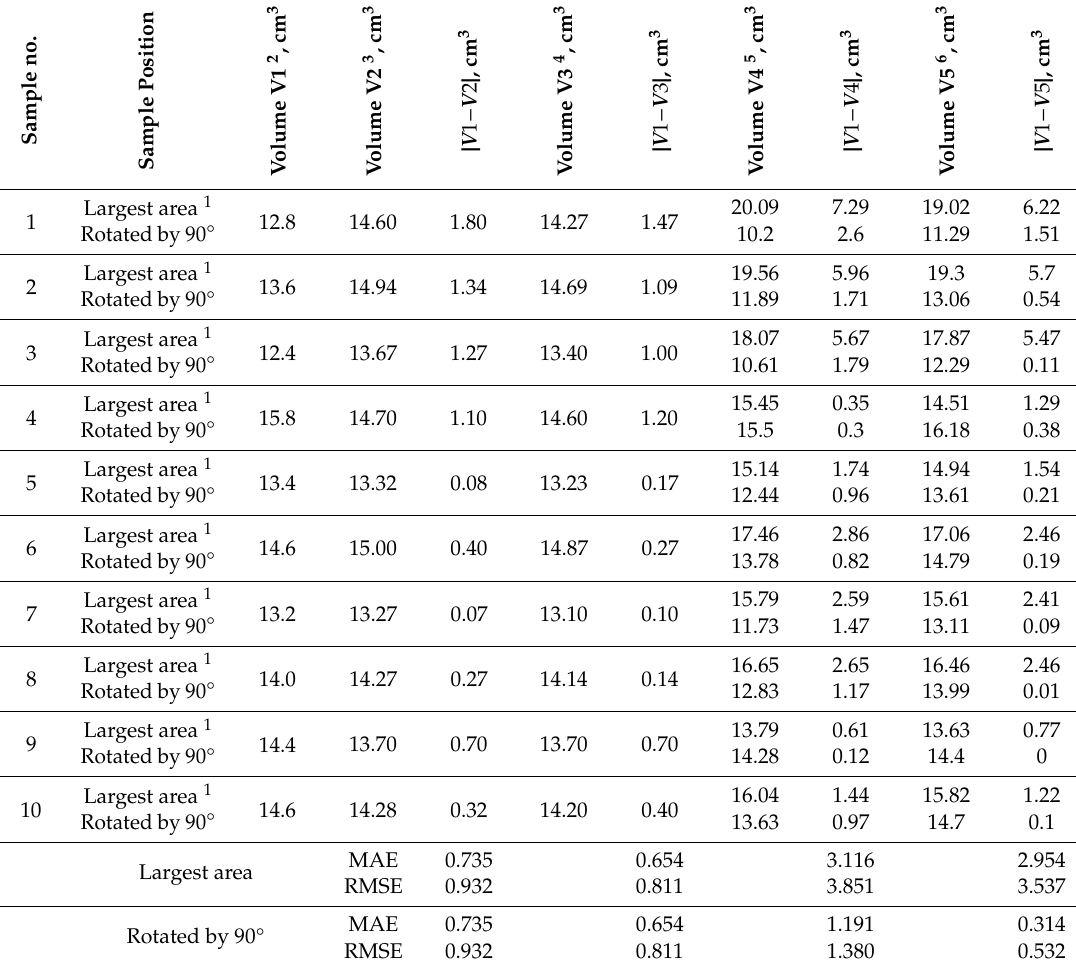
Table 2. Di ff erences between calculation of volume of pellets using direct method and pellet division to circular and elliptical